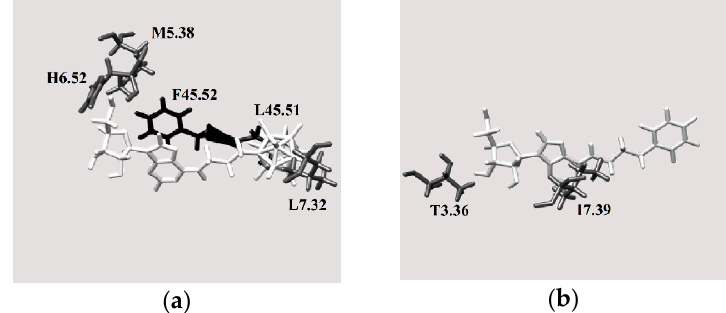
Figure 8. Views of the A2A receptor binding pocket showing the best docked poses of ( a ) compound 3 and ( b ) compound 4 (white: ligand, gray: transmembrane residues, black: extracellular amino acids).